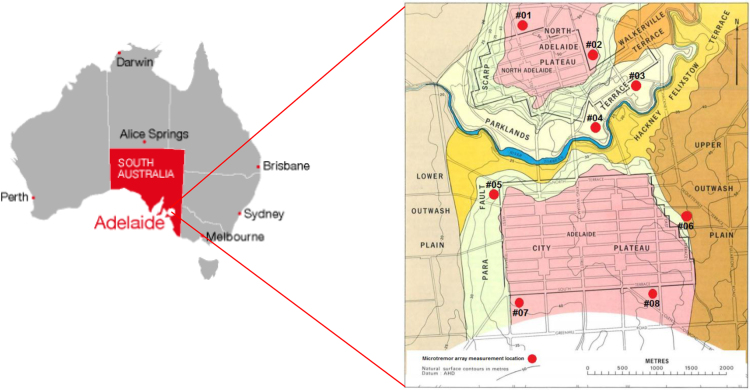
Locality of the collected data sites [5].